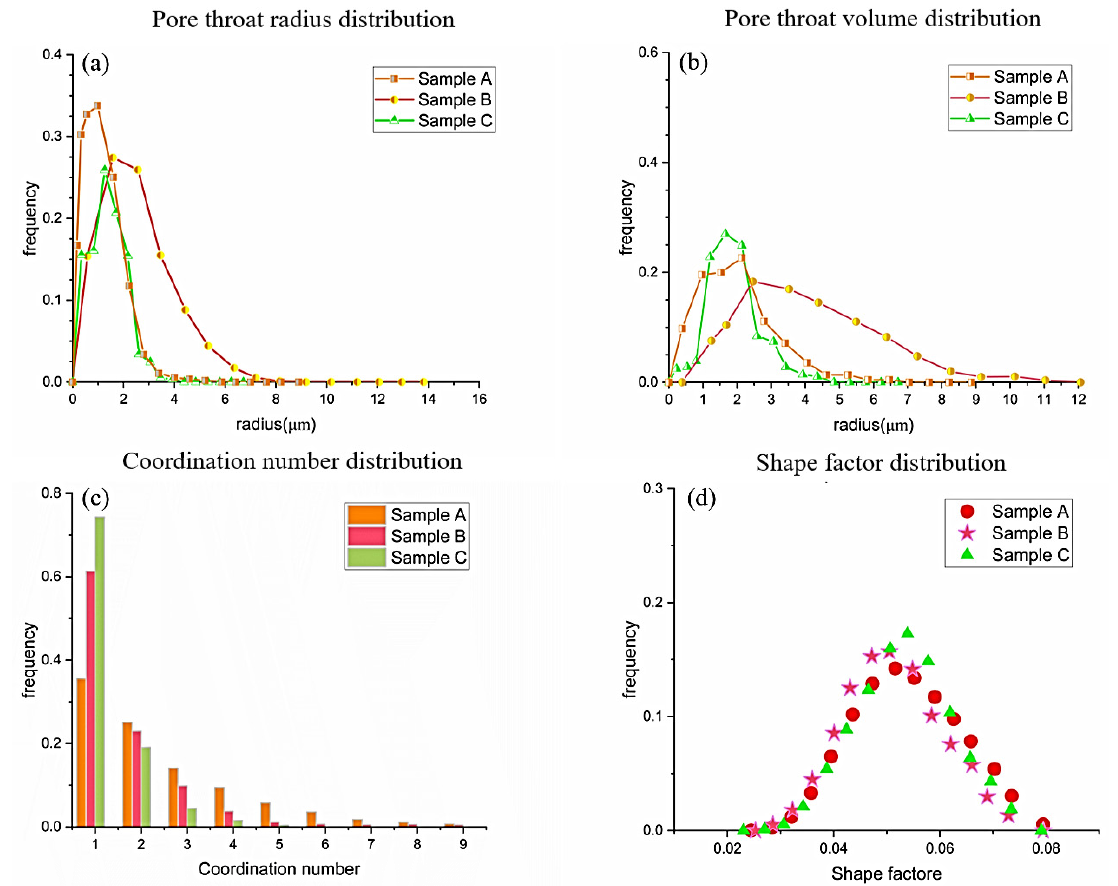
Figure 11. Pore structure parameter distribution. ( a ) pore throat radius distribution statistics; ( b ) pore throat volume distribution statistics; ( c ) pore coordination number statistical histogram; and ( d ) shape factor distribution